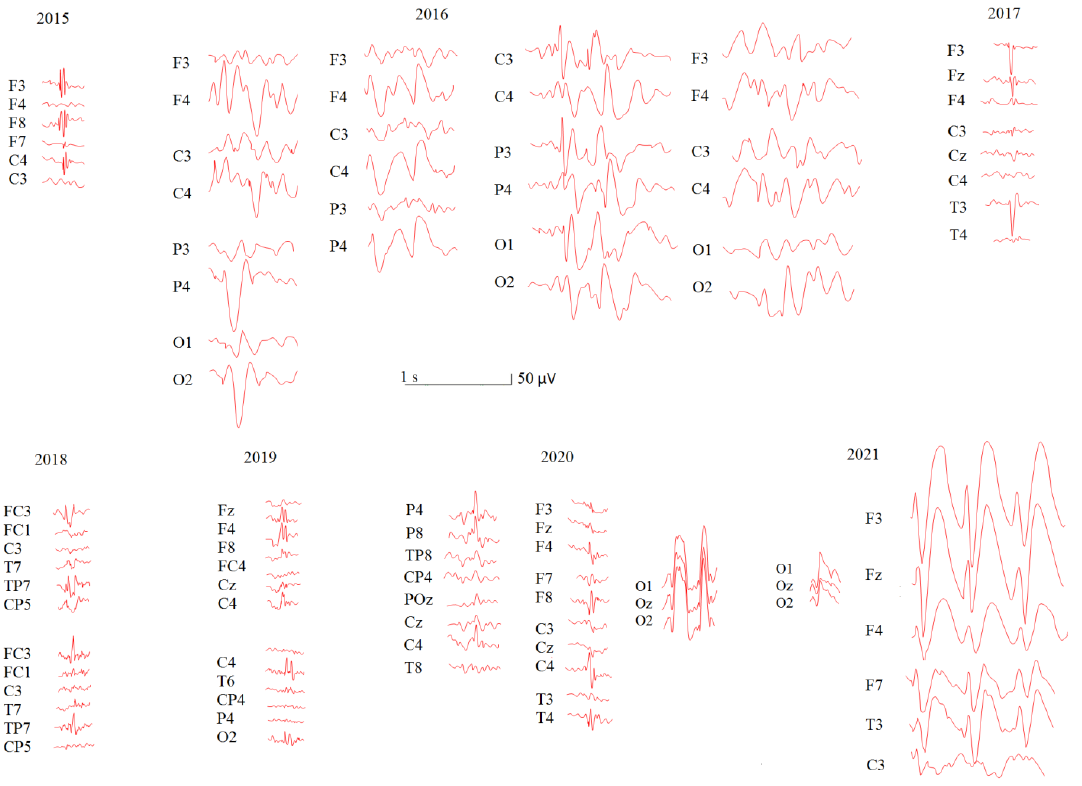
Figure 1. Epileptic EEG abnormalities in patient U during the course of the disease. The EEG recordings marked by stars in Table 2 were used for the visualization.